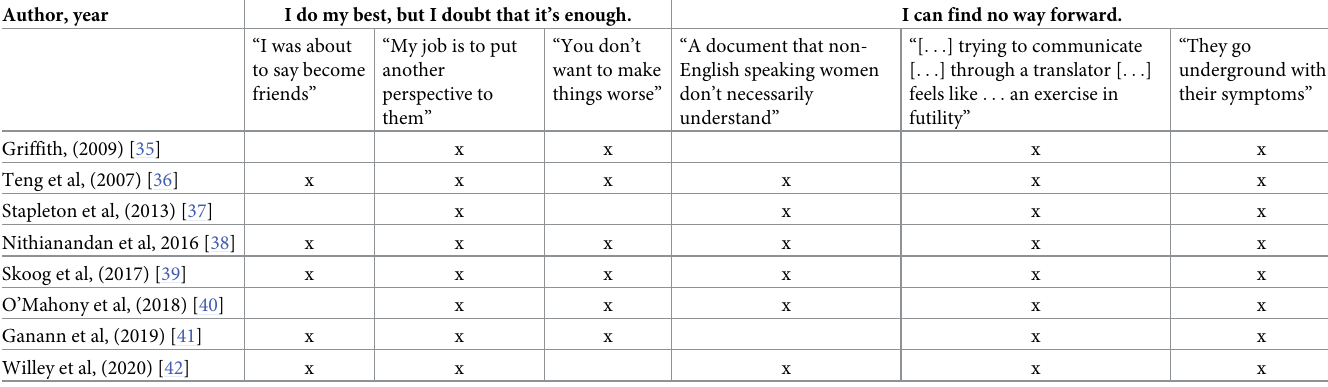
Table 3. Individual study concepts as related to the emerging themes and final themes. Author,